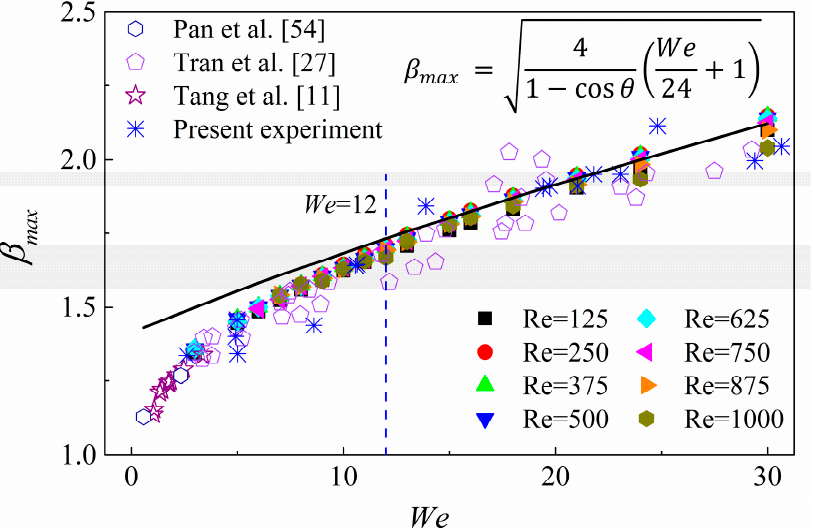
Figure 8. Comparison between the present experimental results (denoted by the stars), Tang et al.’s experimental results (denoted by the pentagram symbols) [11], Tran et al.’s experimental results (denoted by the pentagon symbols) [27], Pan et al.’s experimental results (denoted by the hexagon symbols) [54], numerical predictions (denoted by the solid symbols) and the Wildeman et al.’s model [40] (denoted by the solid line) for dimensionless droplet maximum spreading diameter β max under small Weber numbers ( 𝑊𝑒 ≤ 30 ).